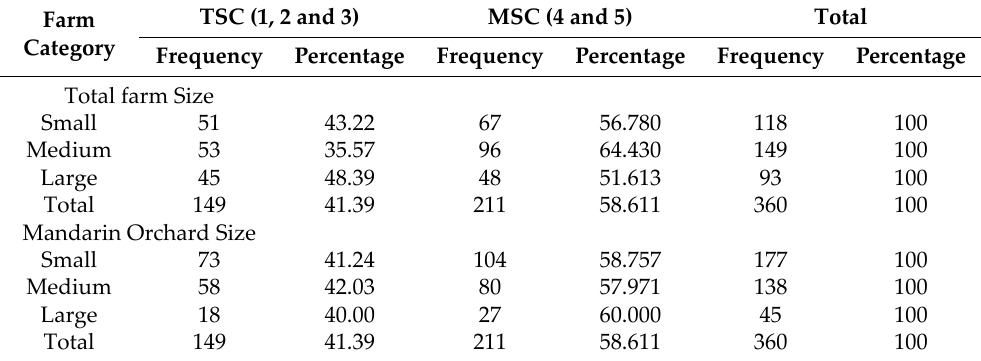
Table 3. Distribution of mandarin farmers within TSC vs.